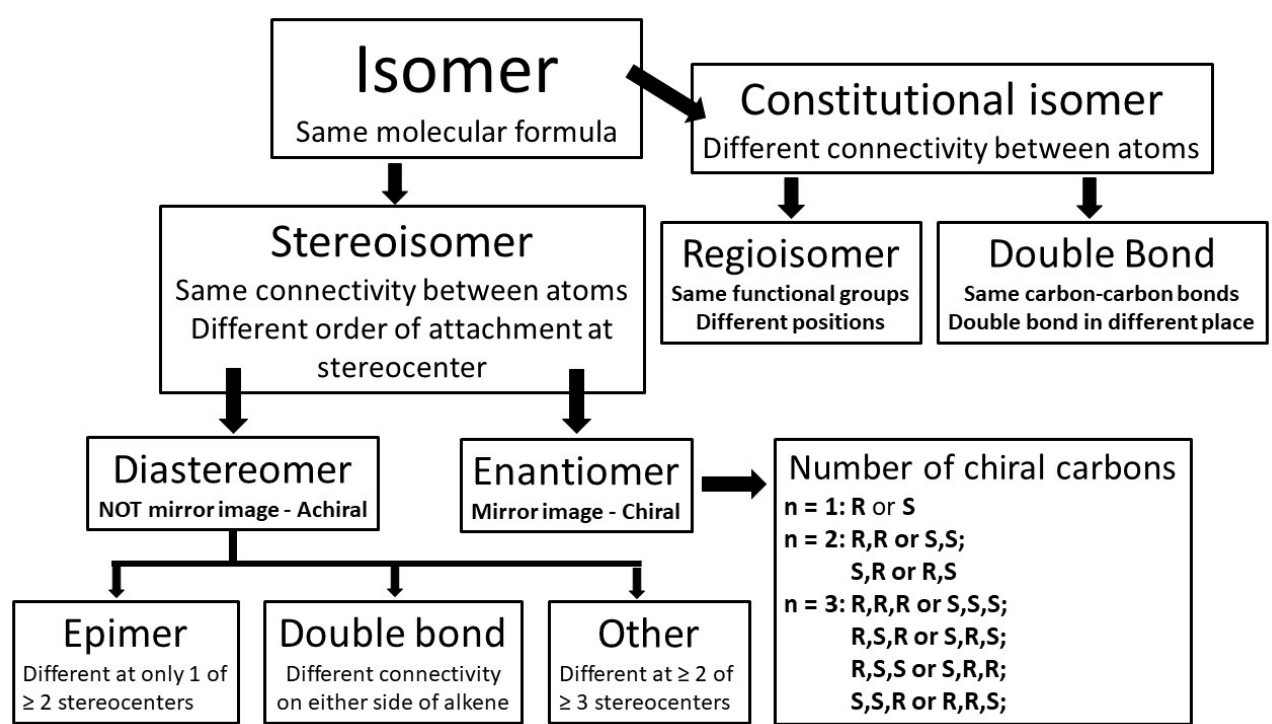
Figure 10. Isomer hierarchy in organic chemistry nomenclature.